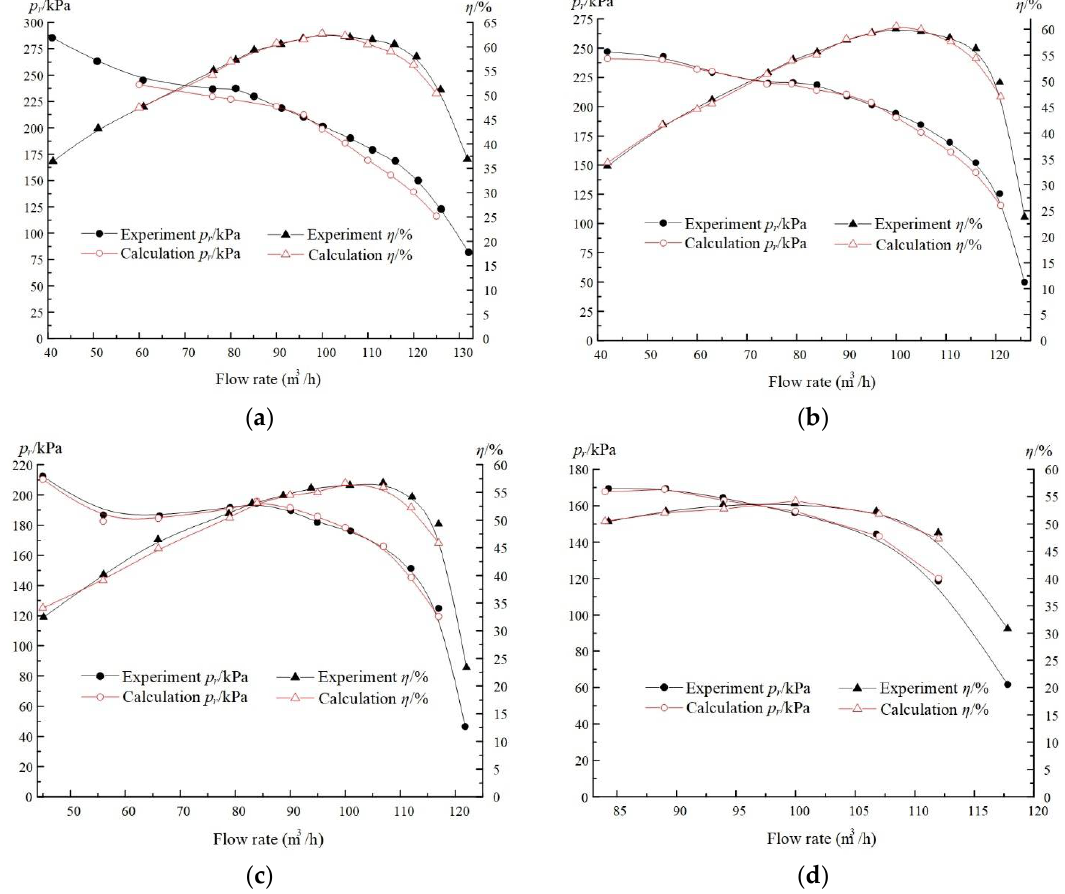
Figure 5. Comparison of pump performance between experimental and numerical results. ( a ) GVF = 0%; ( b ) GVF = 5%; ( c ) GVF = 10%; ( d ) GVF = 15%.